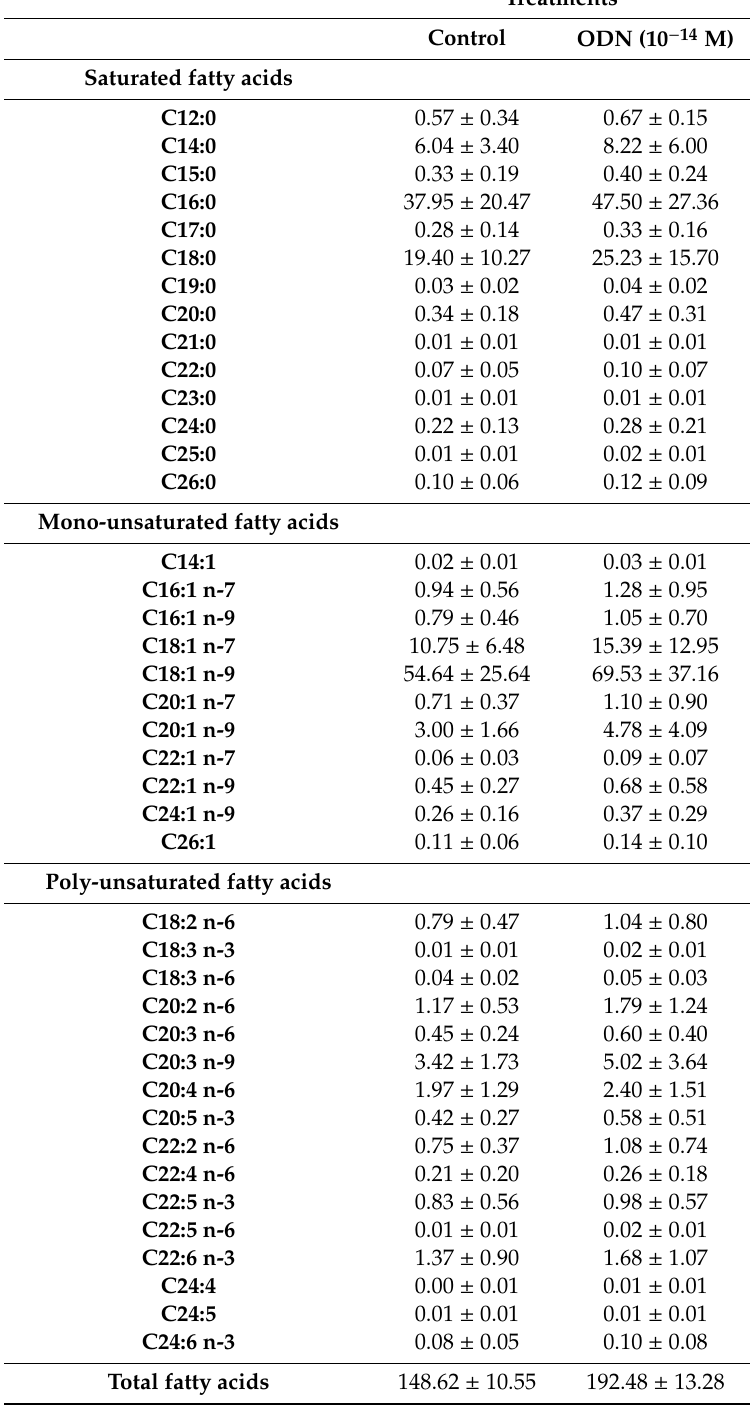
Table 2. Murine neuronal N2a cells, previously cultured for 24 h in conventional cultured medium, werefurtherculturedfor48hinmediumwithoutFBSinthepresenceorabsenceofoctadecaneuropeptide (ODN 10 − 14 M). The level of long chain fatty acids (LCFA: C12 < LCFA < C22) and very long chain fatty acids (VLCFA: ≥ C22) was determined by GC / MS. Data are expressed in nmoles / 10 6 cells, and each value are mean ± standard deviation (SD) of 3 independent experiments. Statistical analysis: ANOVA followed by Bonferroni’s test: * p < 0.05; ODN-treated cells versus untreated cells (control). No significant di ff erences were observed between control and ODN treated cells (Mann-Whitney